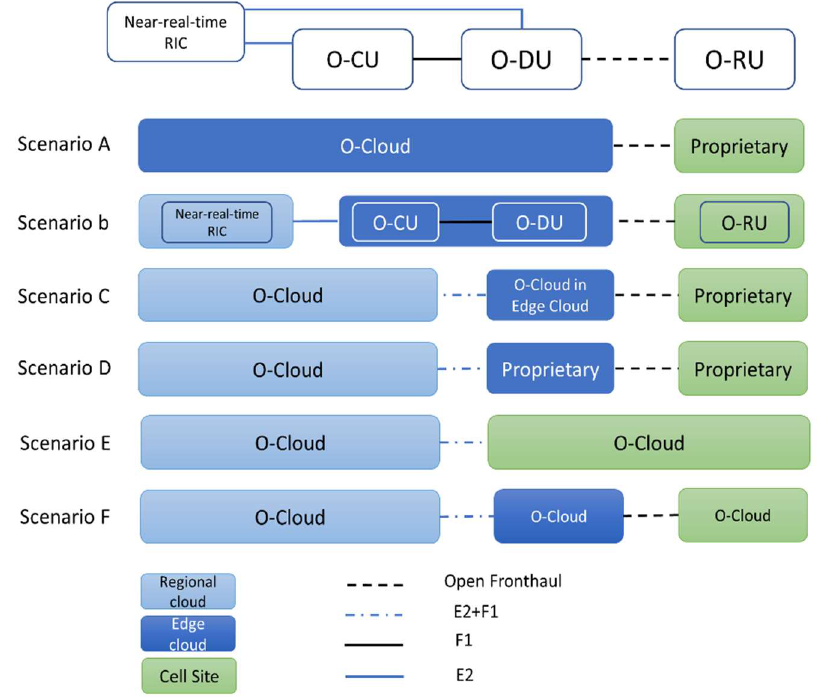
Figure 1. O-RAN deployment scenarios.